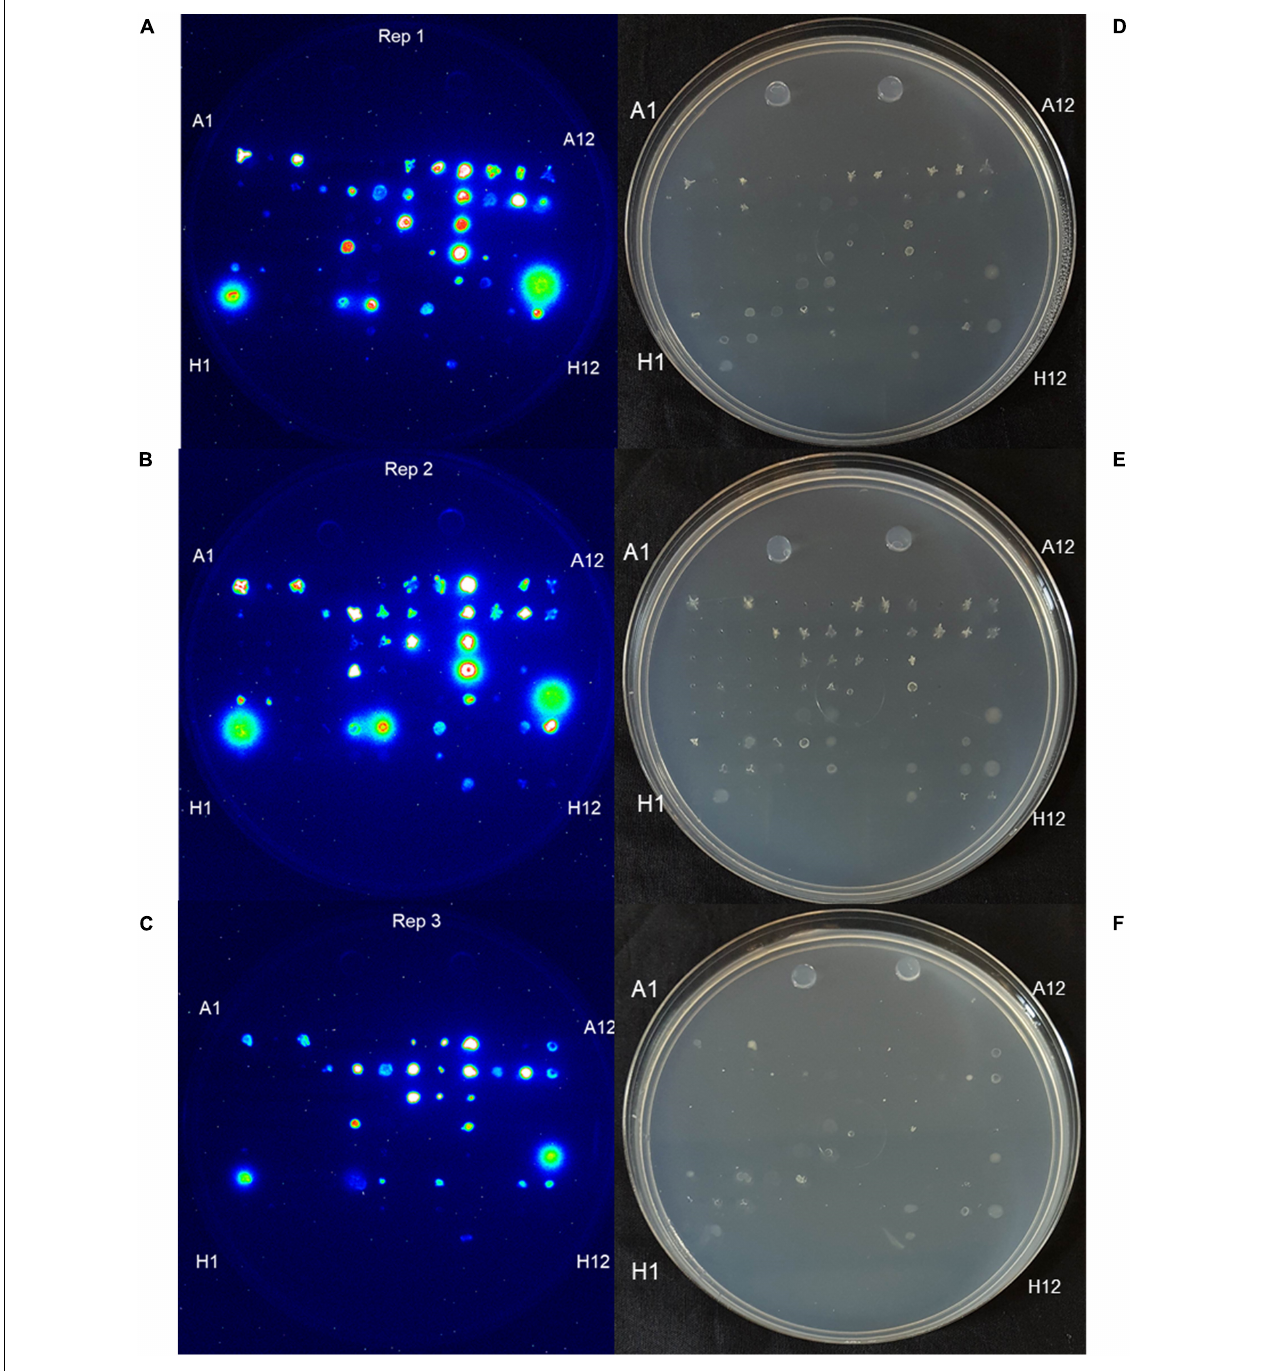
FIGURE 3 | Burk’s GlnLux colony assay to screen the maize endophytes for Gln secretion in vitro on nitrogen-free Burk’s agar. (A–C) Shown is luminescence imaging of three replicates: (A) replicate 1, (B) replicate 2, and (C) replicate 3 of endophytes from Parviglumis and Mixteco that could secrete Gln on N-free agar as indicated by a luminescence signal. (D–F) Corresponding light images of these plates: (D) replicate 1, (E) replicate 2, and (F) replicate 3. Some strains did not grow on this N-free agar as